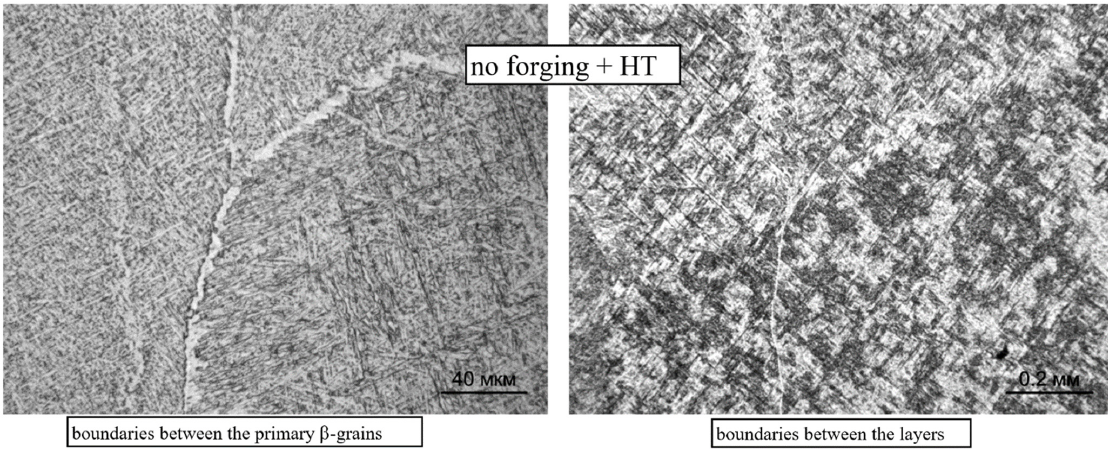
Figure 13. Microstructure and boundaries between primary β -grains (×500) and between layers (×100) during CMT deposition without forging after two-stage annealing.